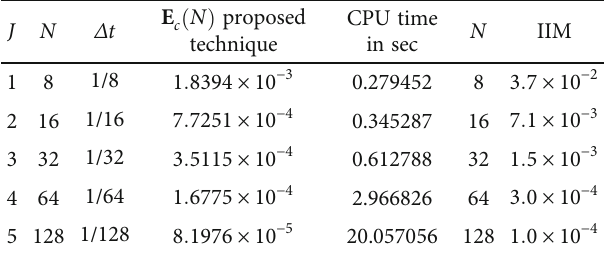
T Þ (b) for Example 1. c ð Table 3: Analysis of errors for Example 3.